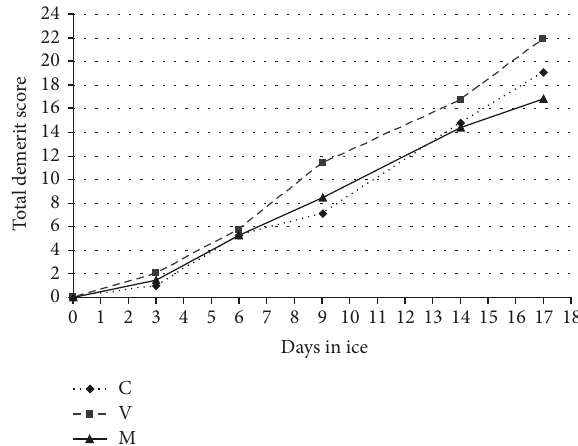
Figure 2: 𝐾 -value (%) of the three rainbow trout groups (C: commercial diet; M: marine diet; V: plant-based diet) stored in ice.